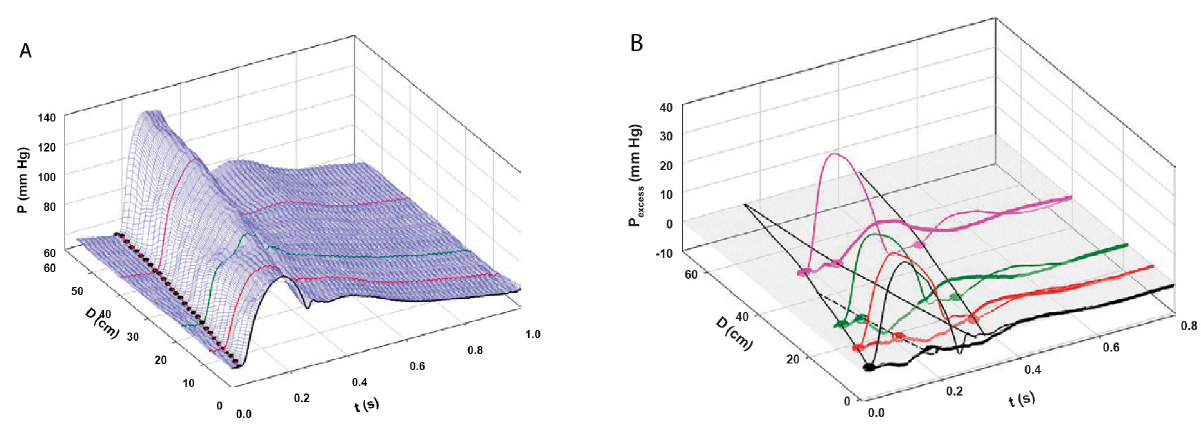
Figure 4. A: Measured aortic pressure ( P ) during one cardiac cycle, plotted as a function of time (t) and distance (d; from the aortic valve to the femoral artery). Black, red, green, and pink lines indicate the sites at which flows were also recorded (respectively, at the aortic root (0 cm), just beyond the left subclavian artery (8 cm), just above the diaphragm (18 cm), and just above the aortic bifurcation (40 cm from the aortic root). The path of the FCW as a function of time and distance is indicated by black dots; B: pressures due to the passage of forward-going waves ( P ; thin lines) and pressures due to the passage excess+ of backward-going waves ( P ; thick lines) were plotted at the locations at which flow was measured. Propagation, distal excess– reflection, and re-reflection and proximal (negative) reflection of the initial FCW are noted in the P = 0 plane. In this and subsequent figures, compression waves will be indicated by filled circles and solid lines and decompression waves, by open circles and dashed lines